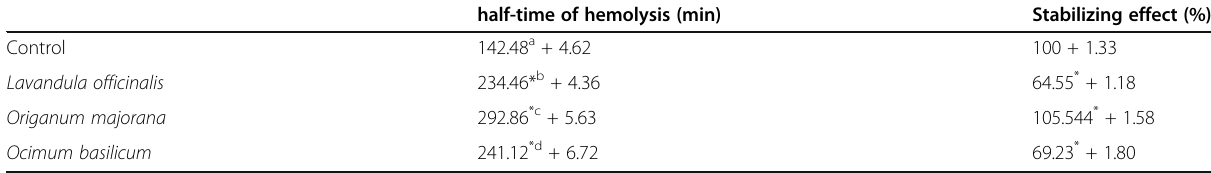
Table 3 Antihemolytic activity and the membrane-stabilizing effect induced by plant extracts half-time of hemolysis